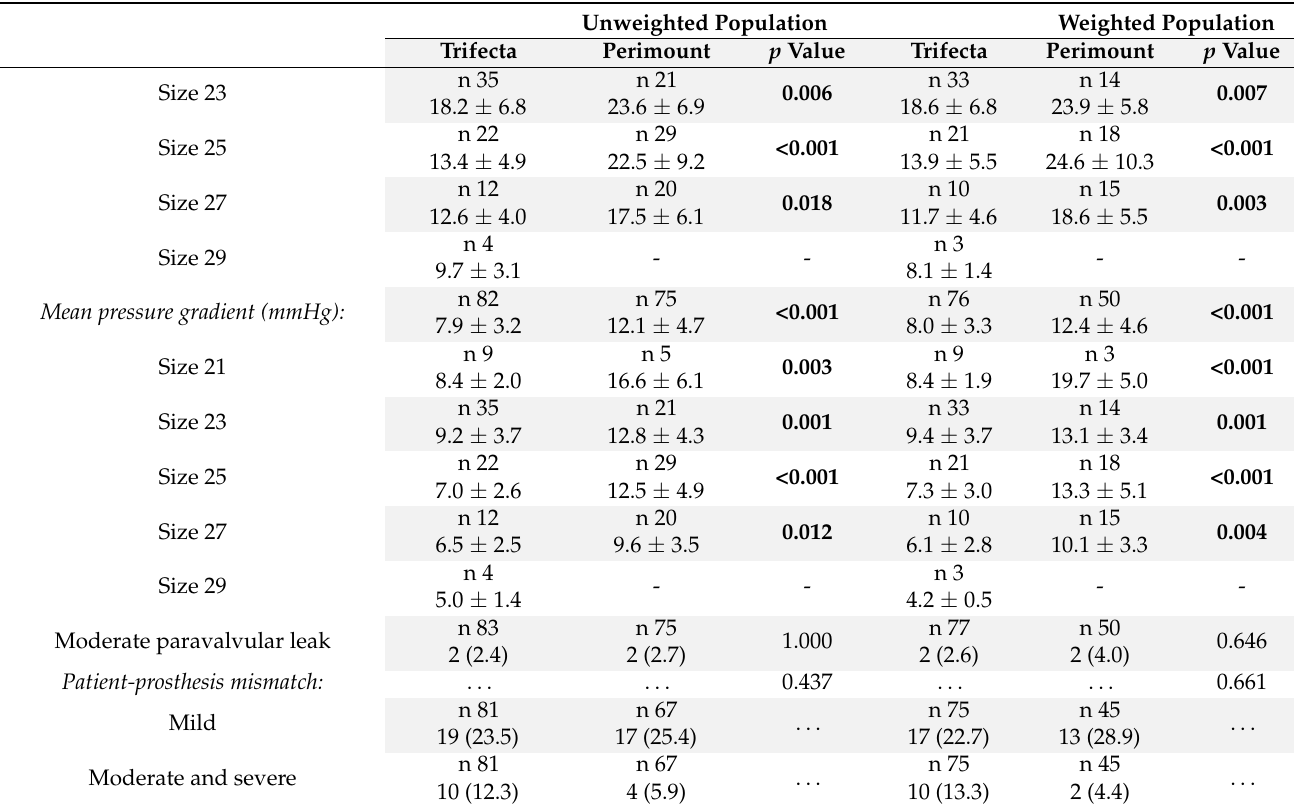
Table 4. Cont. Unweighted Population Weighted